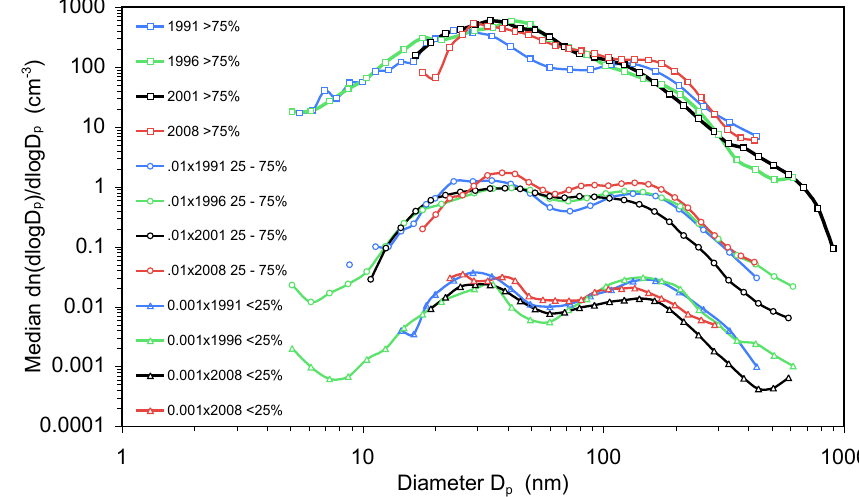
Fig. 5. Median number size distributions in three sub-population of hourly averages of the 1991, 1996, 2001, and 2008 in-ice data: Less than the 25% percentile, between 25 and 75% percentile and larger than the 75% percentile of total number concentration N taken over all four years. The data for the sub-populations 25–75%, and < 25% have been multiplied by factors of 0.1, and 0.01, respectively, in order to avoid overlap in the graph.